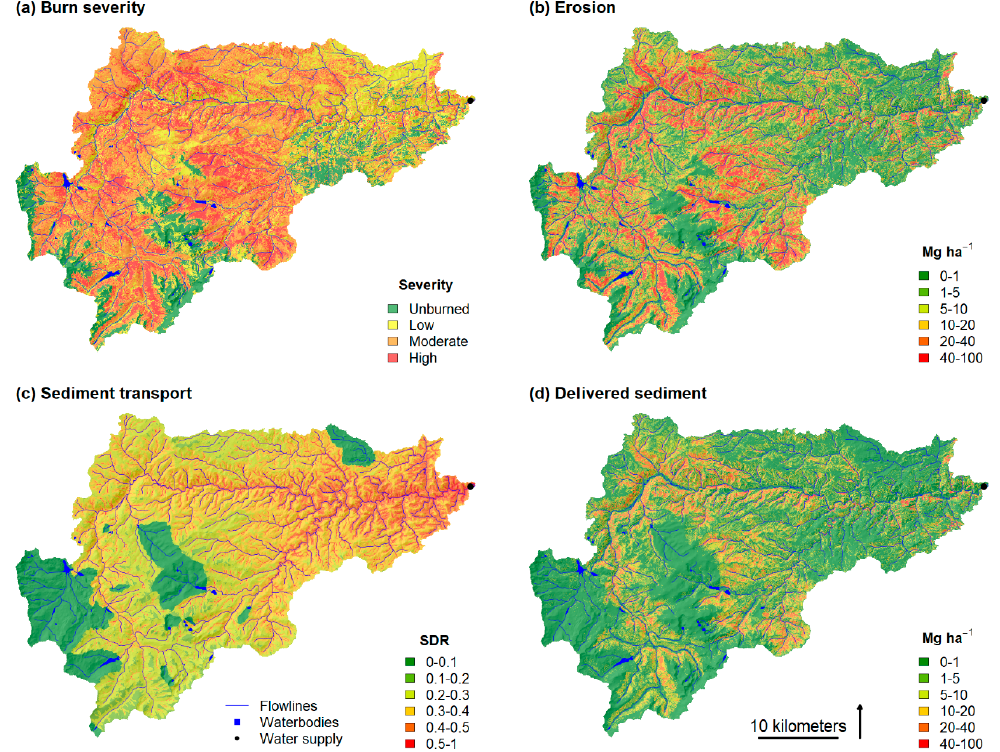
Figure 4. ( a ) Predicted burn severity using crown fire activity categories of surface, passive crown, and active crown fire as proxies for low, moderate, and high severity fire. ( b ) Predicted post-fire erosion with 2-year rainfall erosivity. ( c ) Combined Sediment Delivery Ratio (SDR) accounting for both hillslope and channel transport. ( d ) Predicted sediment delivery to the water supply diversion with 2-year rainfall erosivity.